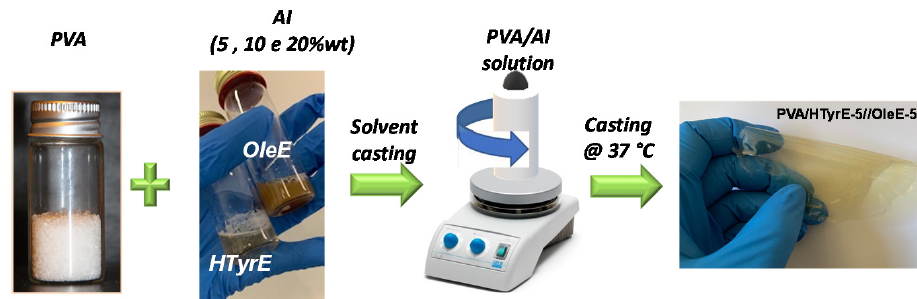
Figure 12. Procedure for the preparation of novel PVA